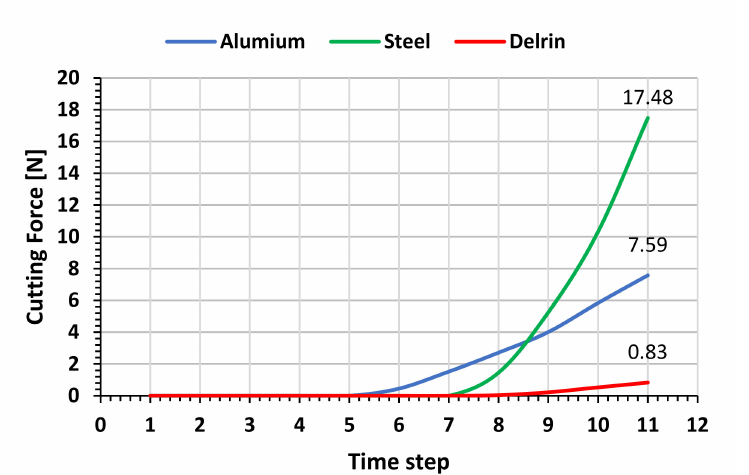
Figure 16. Resulting force for aluminum, steel, and plastic from simulations with LS-Dyna during the tool penetration into the